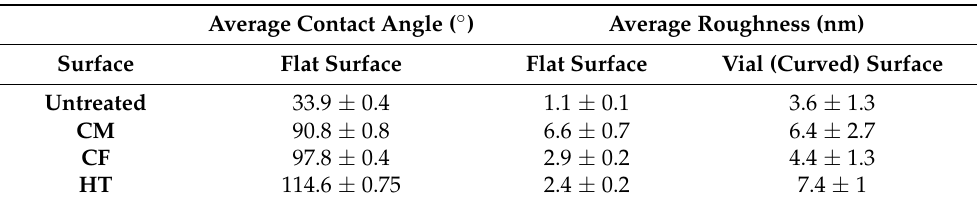
Table 1. Summary of average contact angles and surface roughness measurements of the hydrophilic and hydrophobic glass substrates.